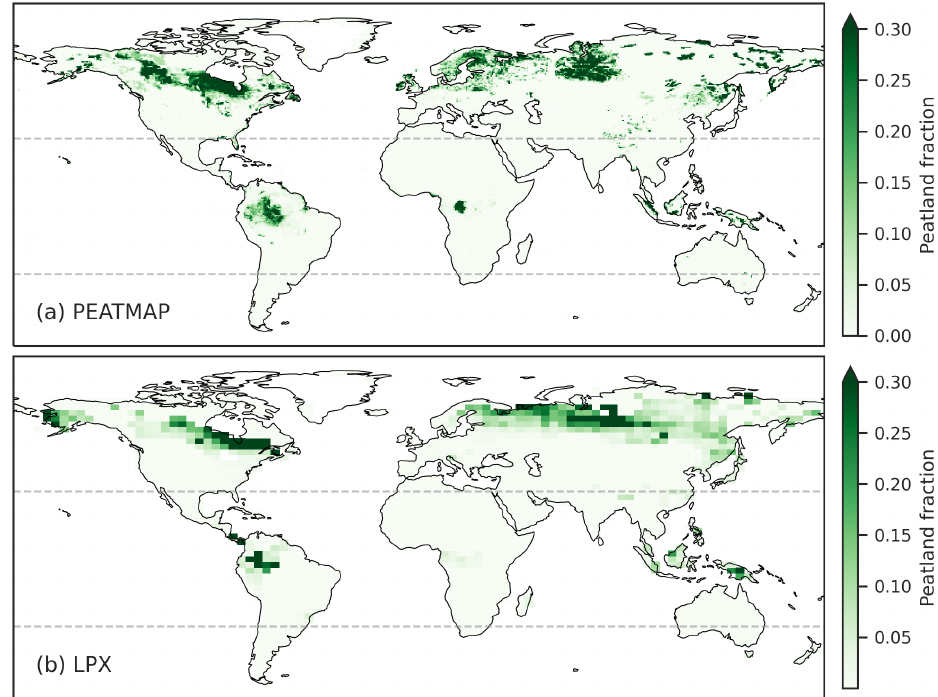
Figure 3. Global peatland area fraction as (a) estimated by PEATMAP (Xu et al., 2018b), shown here in a 0.5 ◦ × 0.5 ◦ gridded version, and (b) simulated by LPX in the year 1975 after a transient simulation from the Last Glacial Maximum.